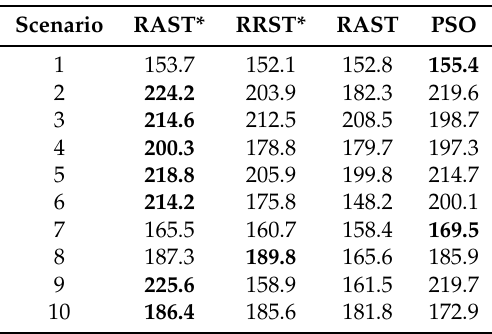
Table 4. Information gathering of RAST*, RRST*, RAST, and PSO over ten randomly selected scientific interest areas with 100 × 70 grids. The maximum information gathering for each scenario has been highlighted in bold.